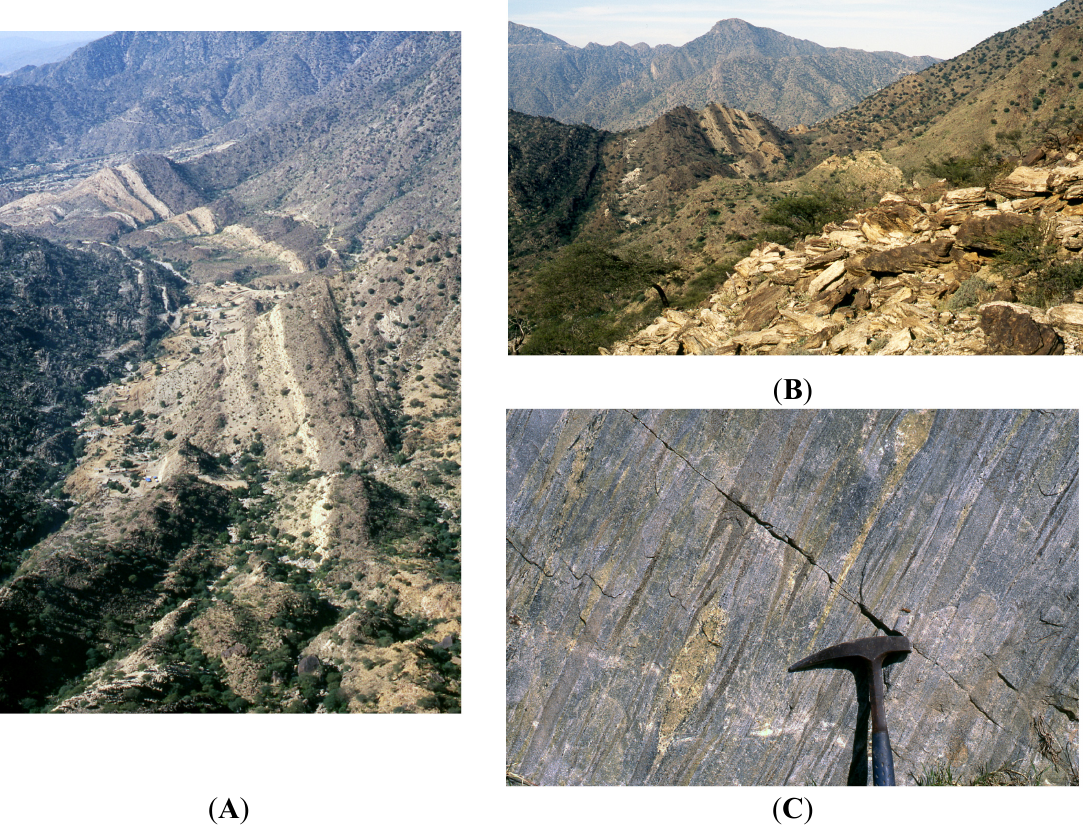
Figure 4. Lithologic and structural features of the Hali group. ( A ) View, looking west, of a narrow zone of well-bedded Hali group rocks in contact with the An Nimas batholith to the north (slopes on the right hand side of the photo) and the Baqarah pluton to the south (on the left). The Hali group unconformably overlies the An Nimas batholith but, as seen in this view, the group dips steeply north beneath the batholith and the unconformity is overturned; ( B ) Another view of overturned, north-dipping Hali group rocks, showing the flaggy character of psammitic schist; ( C ) Close up of psammitic rocks in the Hali group showing their strongly deformed character with transposed, discontinuous layering, sheared-out intrafolial folds, and stretched epidote-rich